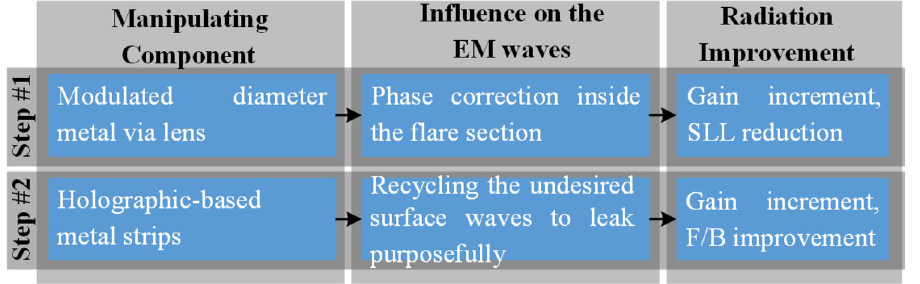
Figure 1. The proposed hybrid technique to enhance the radiation characteristics of the SIW H-plane horn